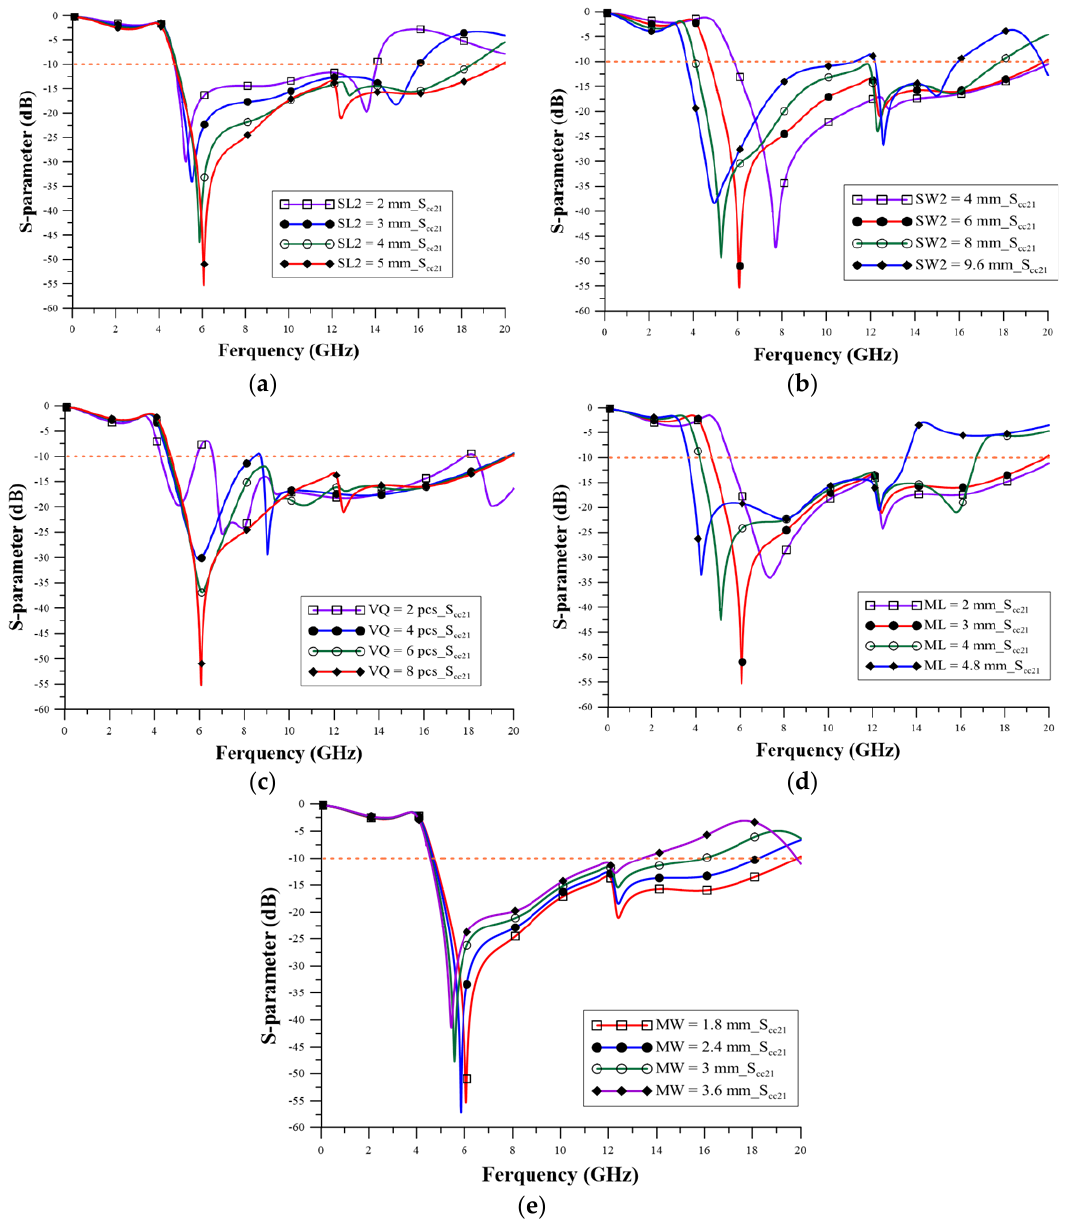
Figure 4. The effect of the geometric parameter changes of the MDCRP filter on the CM insertion loss. ( a ) The length of slot 2 (SL2). ( b ) The width of slot 2 (SW2). ( c ) Via quantity (VQ). ( d ) Mushroom length (ML). ( e ) Mushroom width (MW).